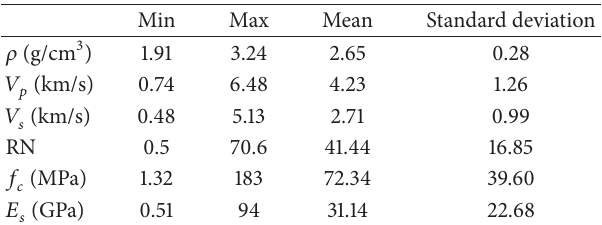
Table 1: Mechanical and physical features of rocks used in experi-